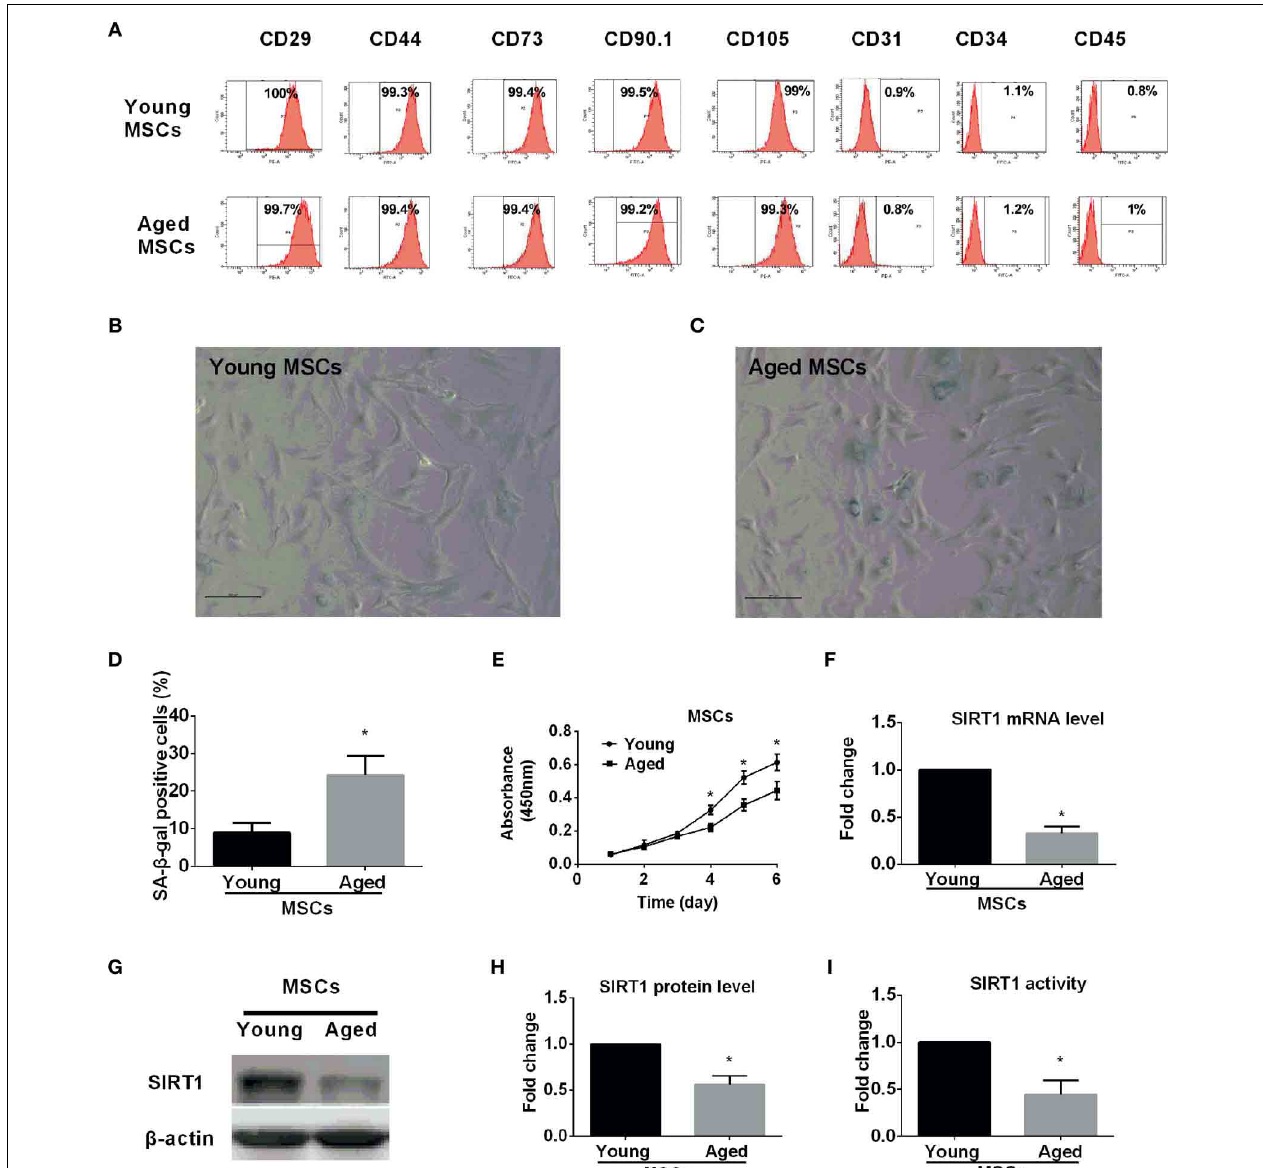
FIGURE 1 | Characterization of young and aged MSCs. (A) Phenotypic characterization of young and aged MSCs by flow cytometry. Representative results showed that both young and aged MSCs were both positive for CD29, CD44, CD73, CD90, and CD105 and negative for CD31, CD34, and CD45. β -galactosidase (SA- β -gal) staining was performed for young (B) and aged (C) MSCs, with percentage of SA- β -gal positive cells shown in bar graph in (D) . Cell proliferation capability was also determined by Cell Counting Kit-8 (CCK-8) method